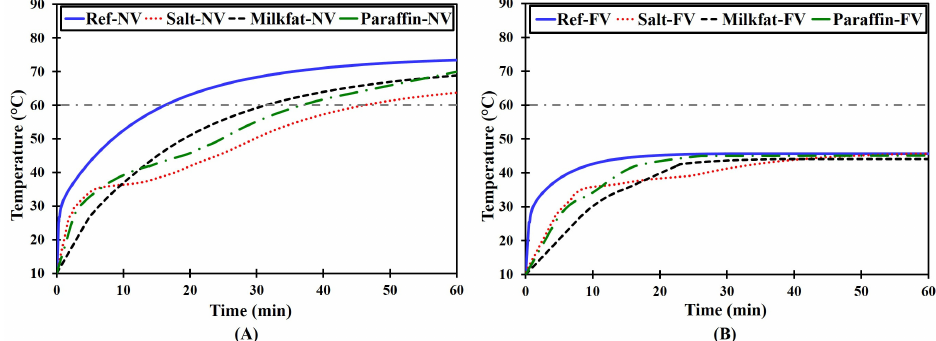
Figure 4. Time ‐ temperature profile on the HS base surface for the complete heating run for three PCMs subjected to: ( A ) Natural ventilation (NV); and ( B ) Forced Ventilation (FV) at heat load of 4 W.